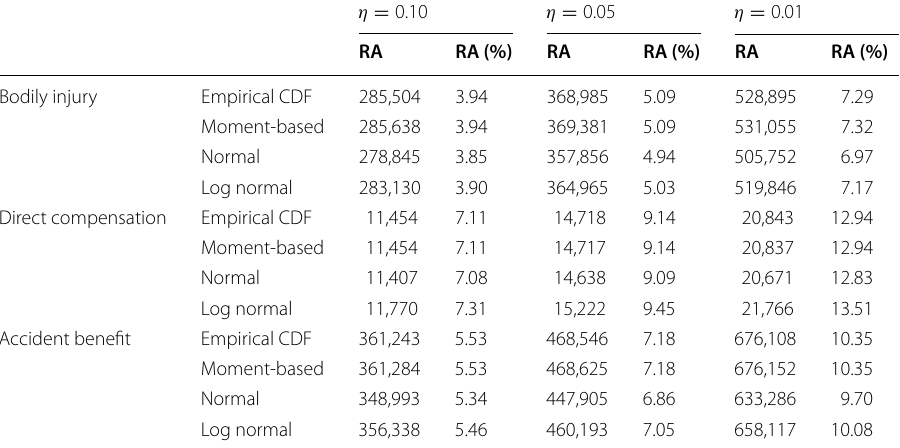
Table 14 Risk adjustments using WT